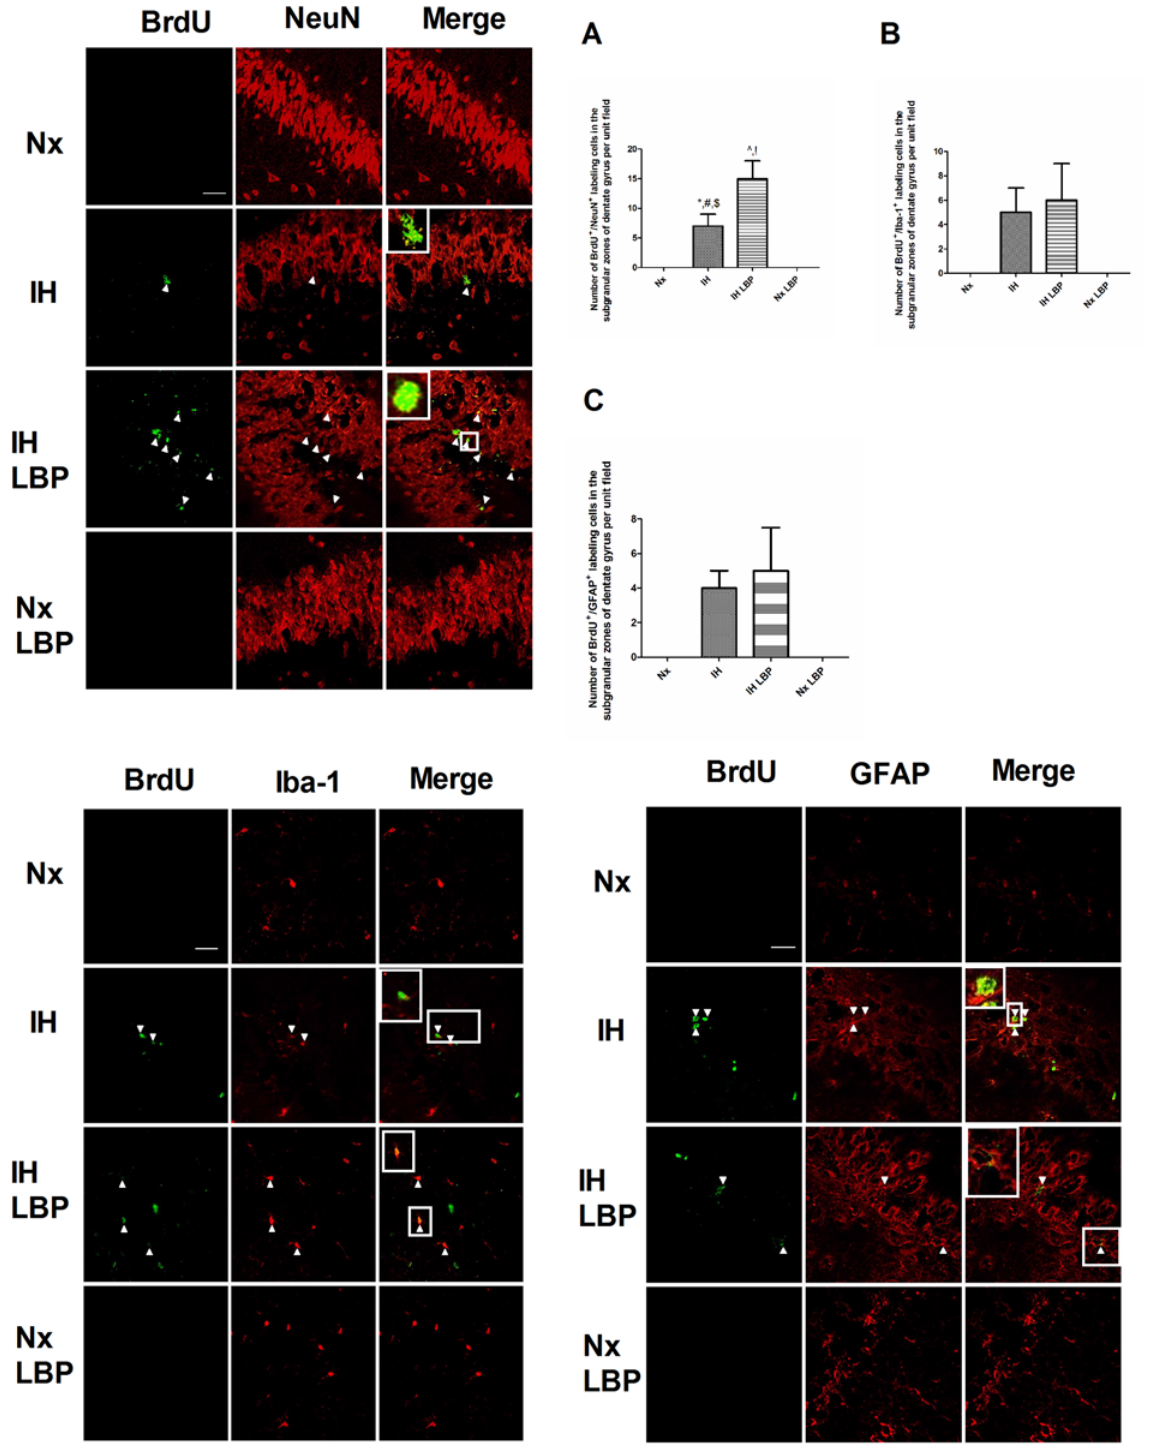
Fig 9. LBP facilitated CIH-induced neurogenesis but not the regeneration of astrocytic and microglia in the SGZ of dentate gyrus of the hippocampus. Number of BrdU + NeuN + counts in the hippocampal SGZ was further increased by the LBP administration in hypoxia-treated rats. Panels A, B and C summarize the number of BrdU + NeuN + , BrdU + Iba-1 + and BrdU + GFAP + respectively. Magnification: 63×; Scale bar: 100 μ